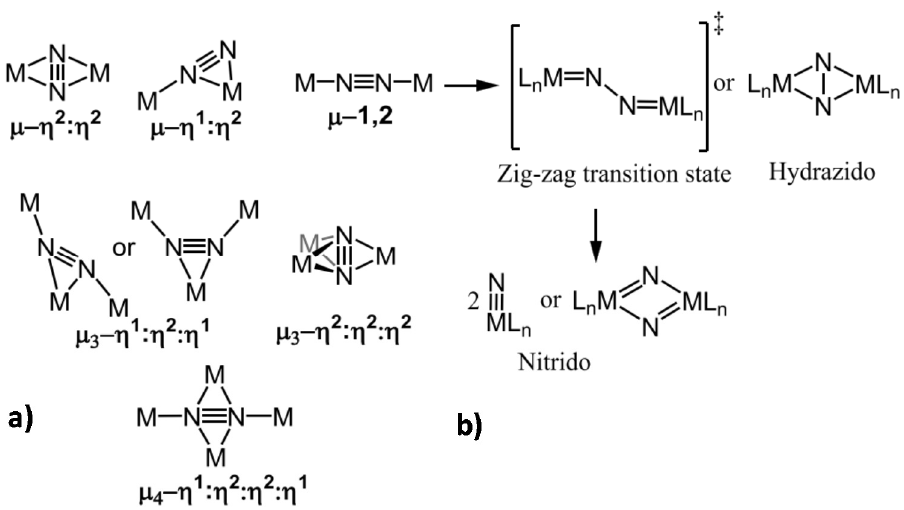
Figure 5. ( a ) Binding bridging modes of N 2 in polynuclear metal complexes. ( b ) Proposed dimetal- lic N 2 scission mechanism. Adapted from [63]. Copyright 2020 American Chemical